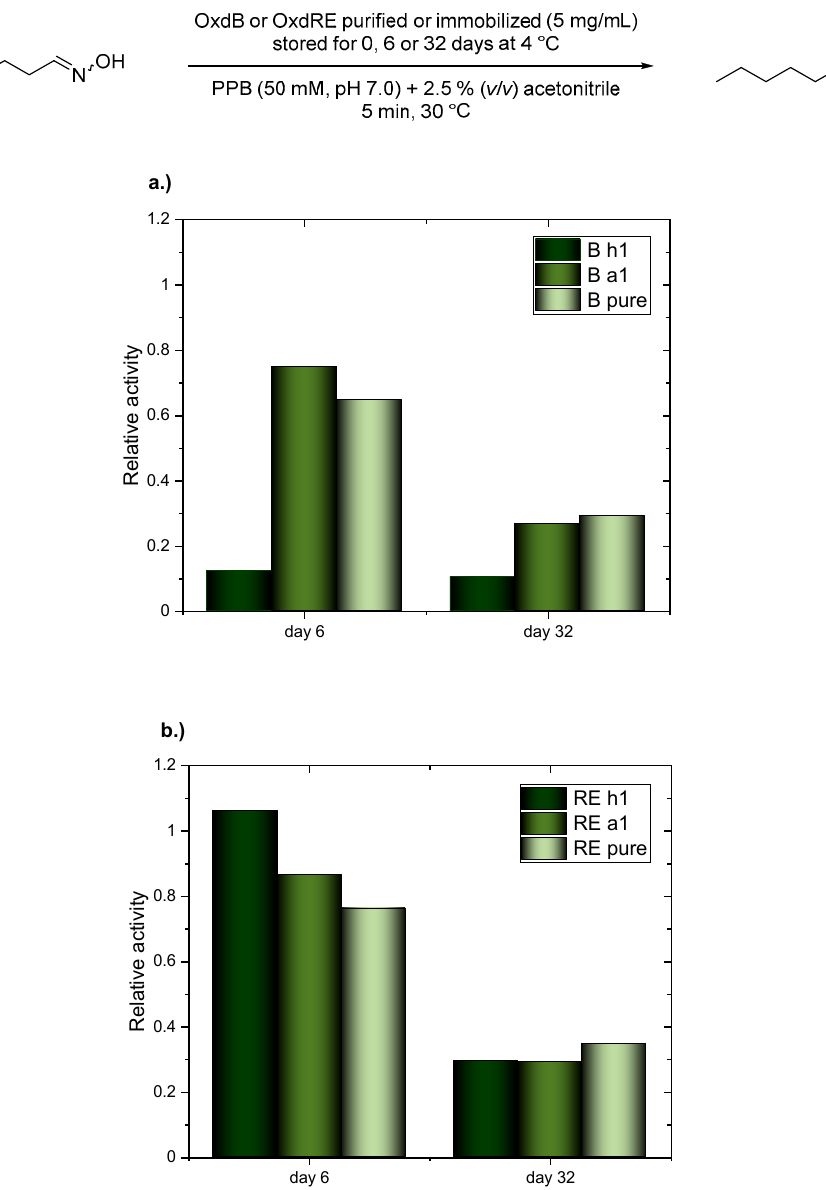
Storage stability assay of purified ( a ) OxdB and ( b ) OxdRE enzymes and h1 and a1immobilizates. The relative activity data refer to the activity measured on the first day (day 0).